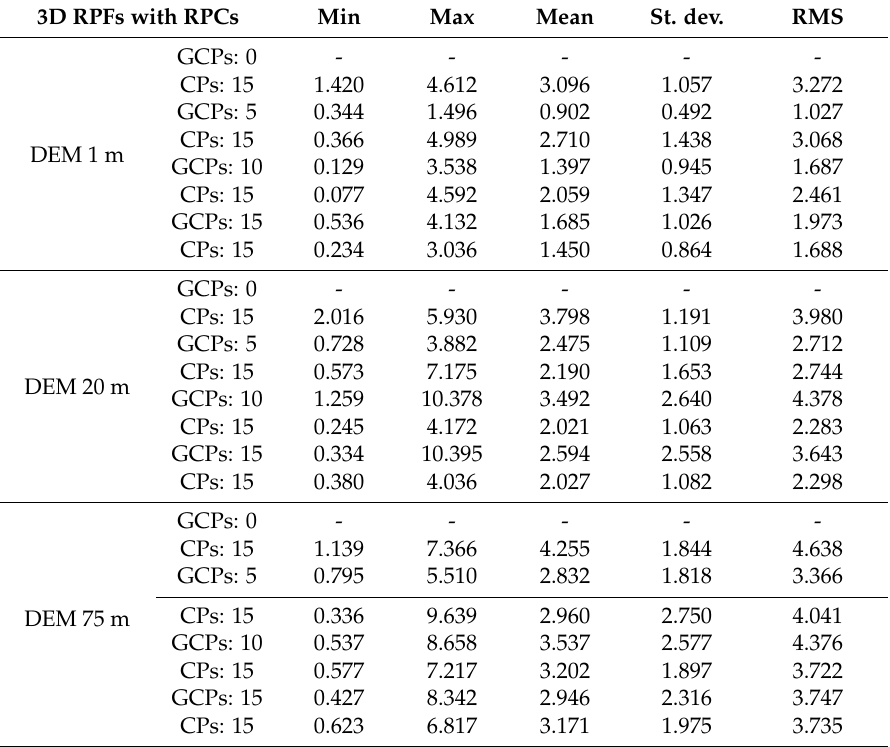
Table 3. Residuals (in meters) obtained for GCPs (0-5-10-15) and CPs using rational polynomial functions (RPFs) with rational polynomial coefficient (RPC) file. 3D RPFs with RPCs